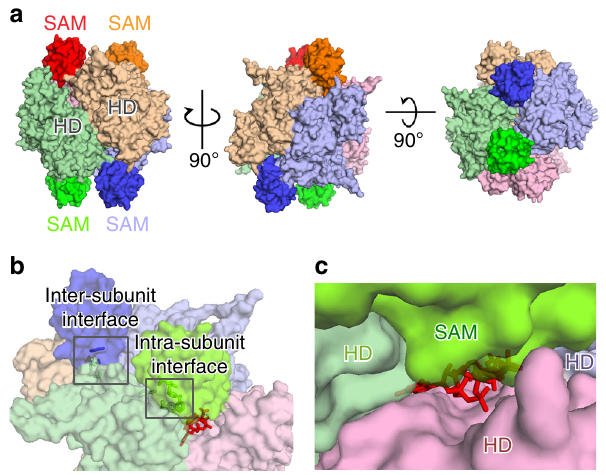
Fig. 2 Crystal structure of full-length mSAMHD1 iso1 in complex with GTP and dGTP (2-Allo). a Surface representation of mSAMHD1 tetramer in three orthogonal views. Each subunit is shown in a different color (purple, orange, red, and green) with SAM domains highlighted. b Surface representation of the 2-Allo structure showing the allosteric binding pocket at the interface of three subunits (purple, red, and green). GTP and dGTP are shown with red sticks and the SAM-to-HD inter- and intra-subunit interactions are highlighted with selected interface residues shown in sticks. c Transparent surface representation of the SAM domain (lime green) capping the allosteric site